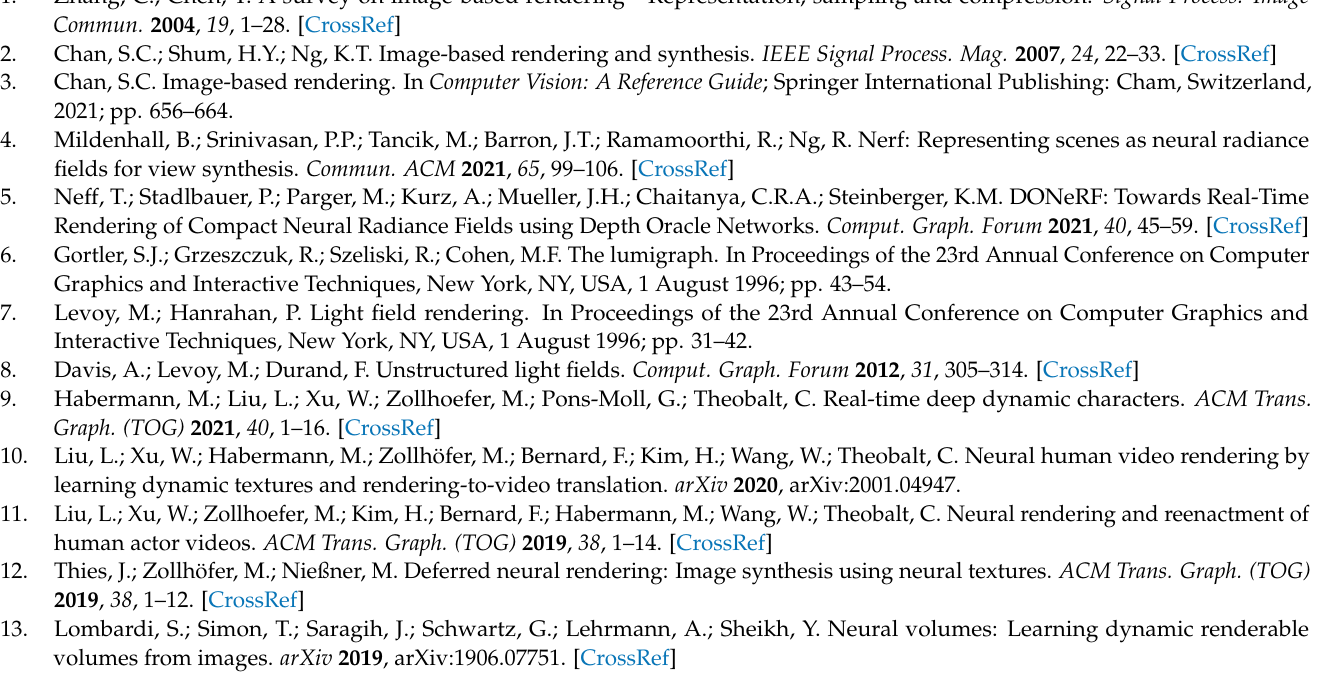
Figure A2. The rendered image of the San Miguel scene and the depth of the test scene are compared with the real image and